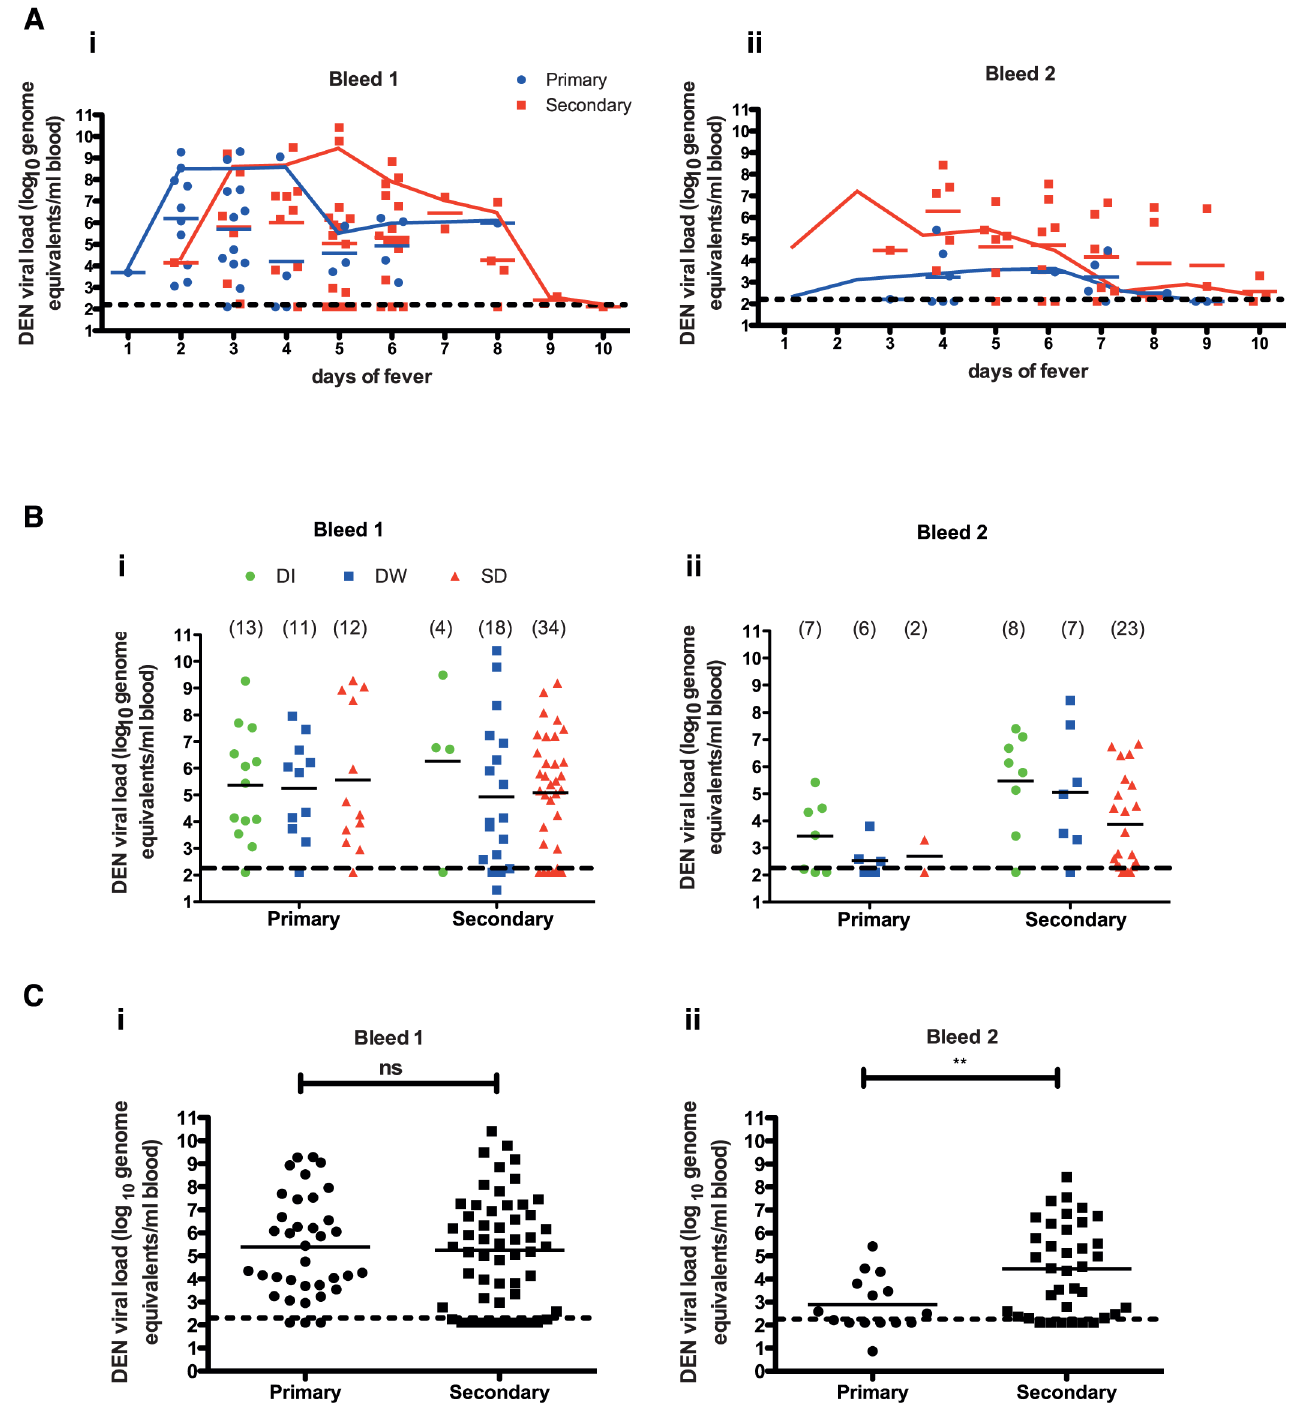
Fig 2. Dengue viremia does not correlate with disease severity. (A) Dengue viral RNA levels in patients classified as primary and secondary dengue infections in bleed 1 (i) and bleed 2 (ii) with respect to the day of fever. An overlapping connecting line graph shows median values of the respective scatter plot. (B) Relationship between dengue plasma viremia and disease severity at the time of admission (i) and 48 h post admission (bleed 2) (ii) in patients with primary and secondary dengue infection. (C) Overall comparison of dengue viremia in all primary and secondary infections in bleed 1 (i) and bleed 2 (ii). Geometric mean value of the scatter plot is shown in all figures. Statistical significance was determined by Mann-Whitney test. ** P =